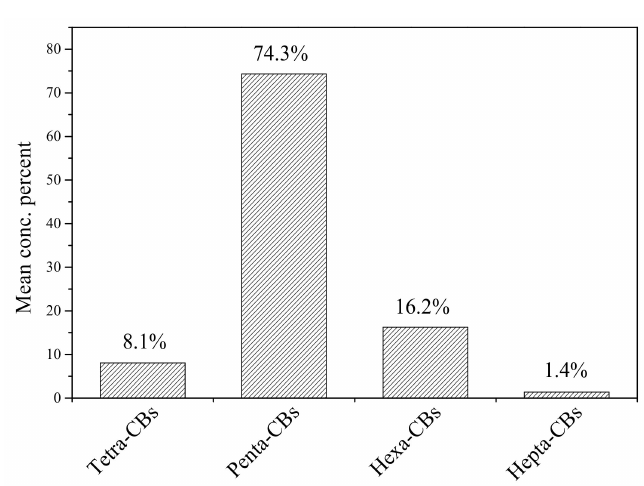
Figure 3. dl-PCB congener profiles in cord serum samples.